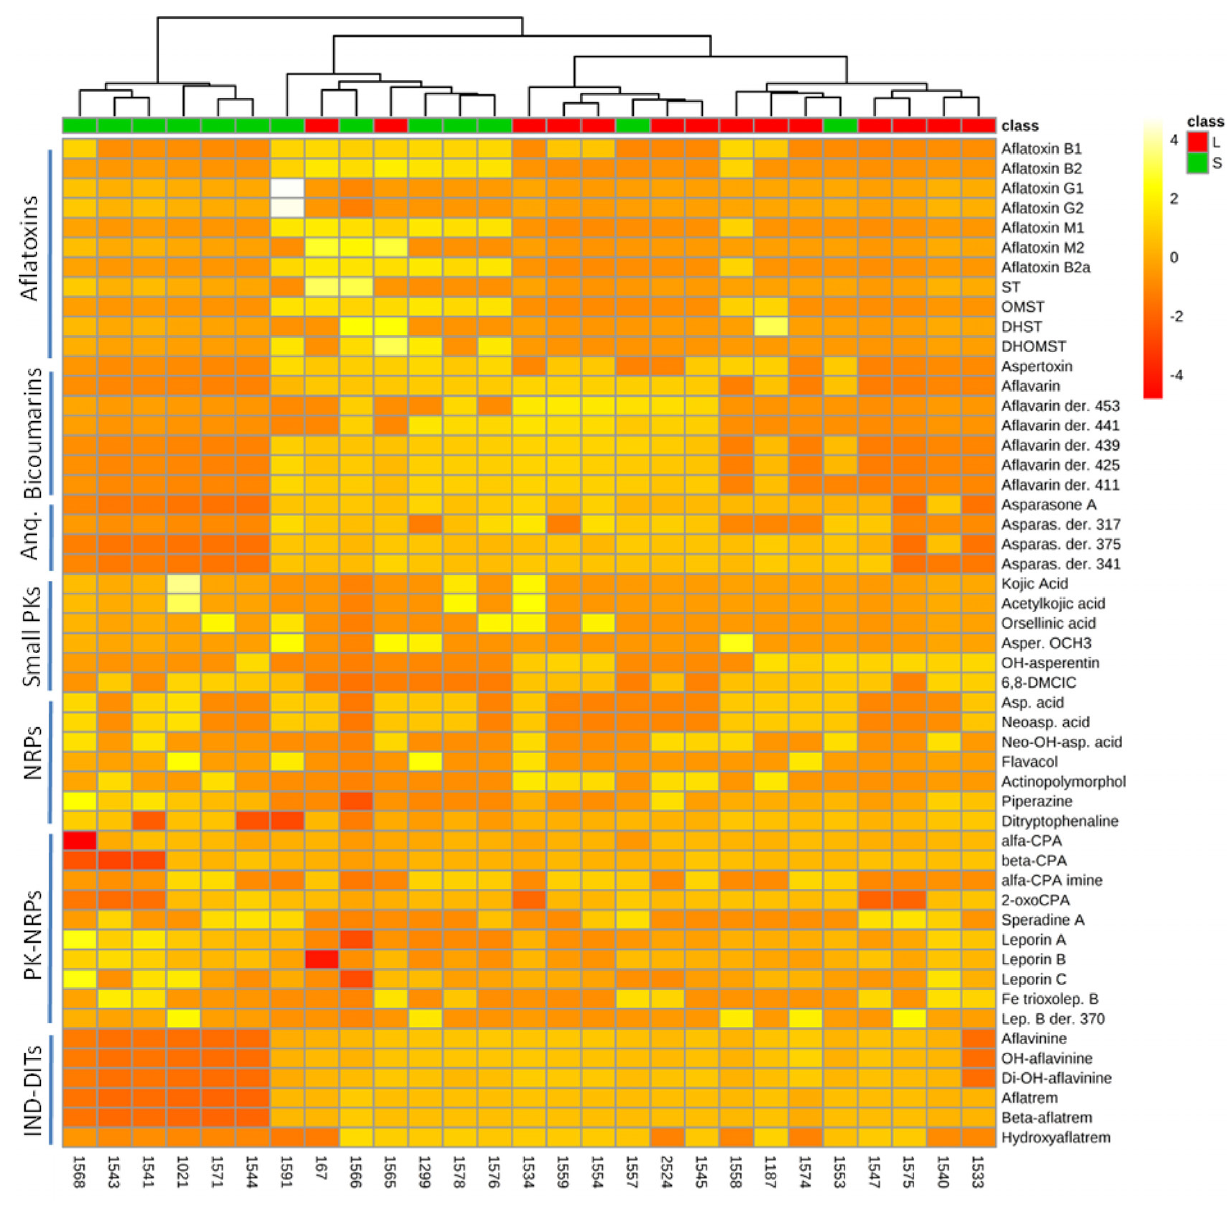
FIGURE 3 | Heat map representing metabolite distribution in 27 A. flavus isolates with assigned sclerotium morphotype. On the top of the figure, a dendogram is depicted, clustering A. flavus isolates as function of sclerotium morphotype: L (large sclerotia > 400 µ m) and S (small sclerotia < 400 µ m). This figure was generated using the online metabolomics platform MetaboAnalyst 3.0 after the data were treated accordingly using sum normalization, log transformations and Pareto scaling. The data table was prepared using AUC foreach chromatographic peak of respective metabolites. Anq, anthraquinones; PKs, polyketides; NRPs, non-ribosomal peptides; IND-DITs, indole-diterpenoids; ST, sterigmatocystin; OMST, O -methylsterigmatocystin; DHST, dihydro-ST; DHOMST, dihydro-OMST; Asparas., asparasone A; Asper. OCH 3 , asperentin methyl-ether; 6,8-DMCIC, 6,8-dimethylcitreoisocoumarin; Asp. acid, aspergillic acid; Neoasp. acid, neoaspergillic acid; alfa-CPA, alfa-cyclopiazonic acid; Lep. B, leporin